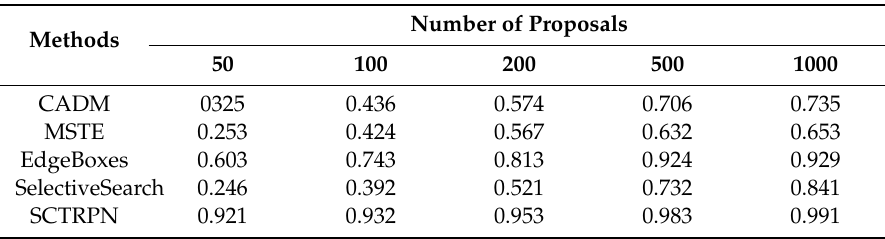
Figure 6. Qualitative proposal generation results obtained by the proposal re-ranking method on some videos of the OTB-2015 dataset. Only top ten generated proposals are shown in the test images. Table 2. The recall obtained by the proposal re-ranking method and the other four competing methods when varying the number of object proposals on the OTB-2015 dataset.